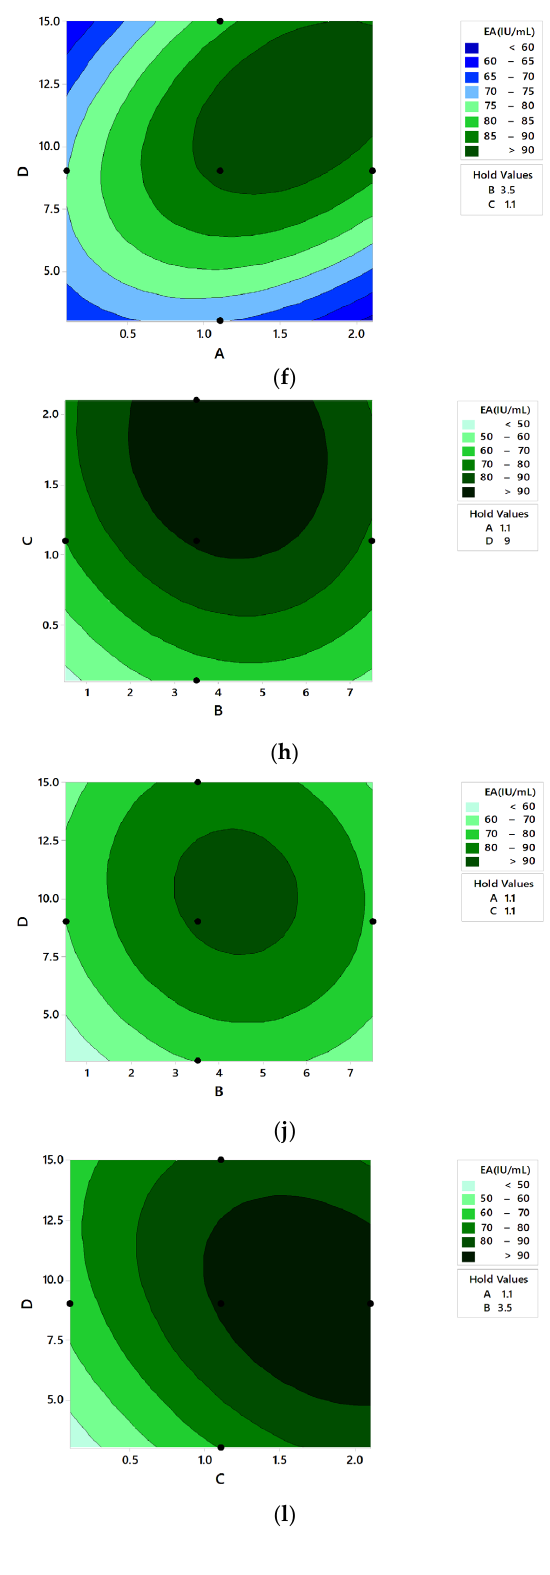
Figure 9. The 3D surface plots and 2D contour plot showing the relative effect of media components on pectinase activity; ( a , b ) peptone and KH 2 PO 4 , ( c , d ) NaH 2 PO 4 and KH 2 PO 4 , ( e , f ) orange Peel and KH 2 PO 4 , ( g , h ) NaH 2 PO 4 and peptone, ( i , j ) orange peel and peptone, and ( k , l ) orange peel and NaH 2 PO 4